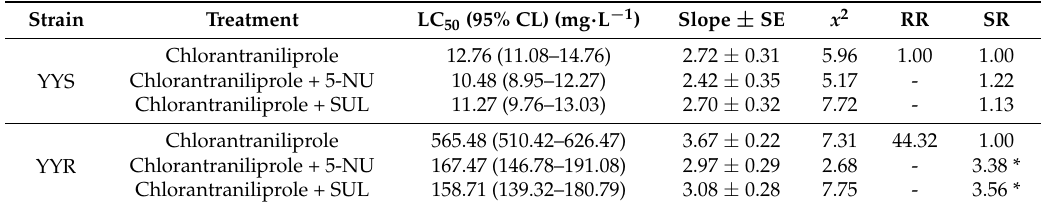
Table 1. Synergism effects of 5-NU and SUL on the toxicities of chlorantraniliprole in the YYS and YYR strains.